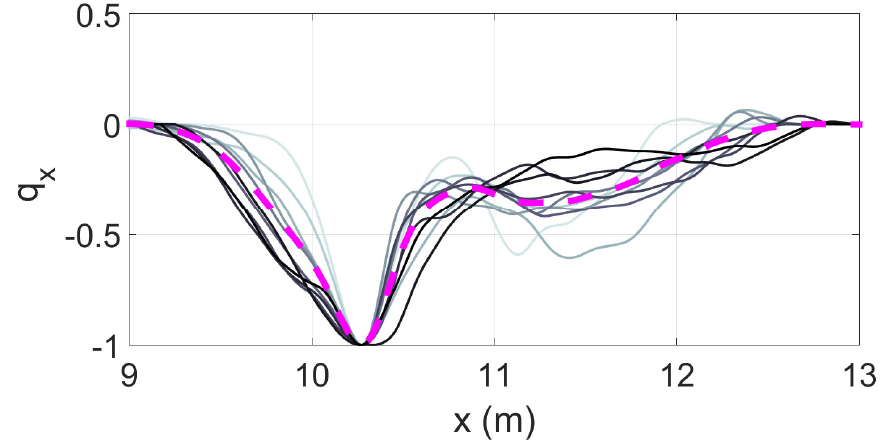
Figure 5. Local sediment transport as presented in Figure 3a, centred and normalized according to the peak in transport, together with the mean transport pattern (dashed magenta line).